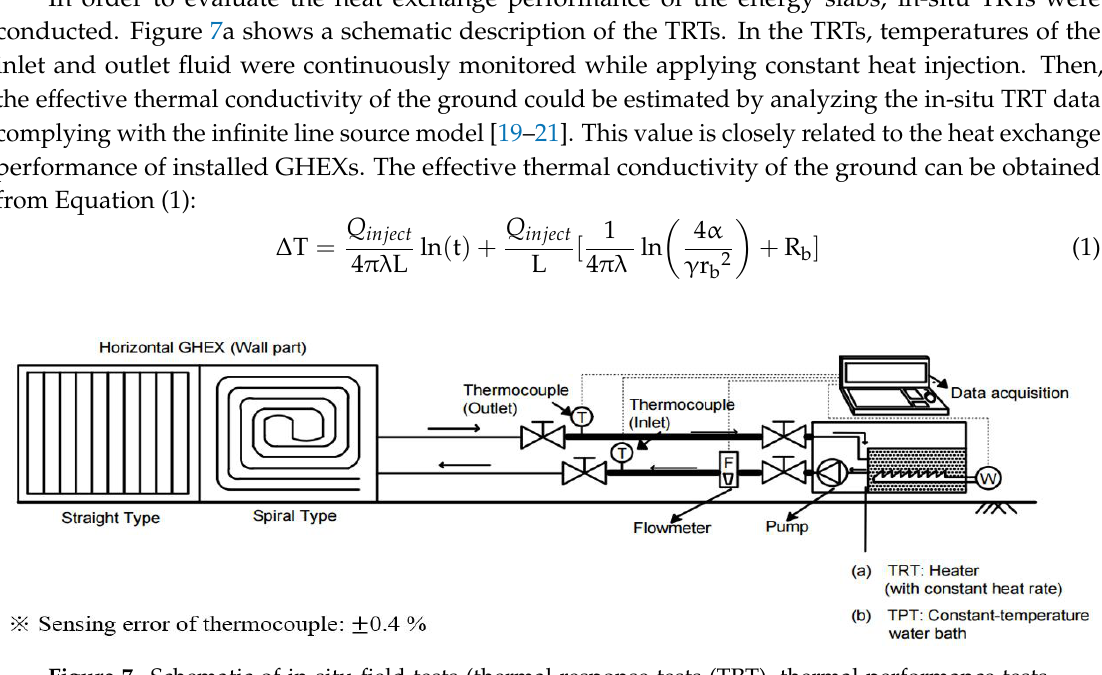
Figure 7. Schematic of in-situ field tests (thermal response tests (TRT), thermal performance tests (TPT)).